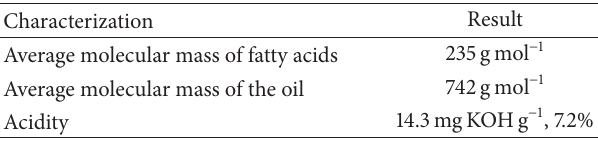
Table 3: Characteristics of the of the Spirulina platensis microalga